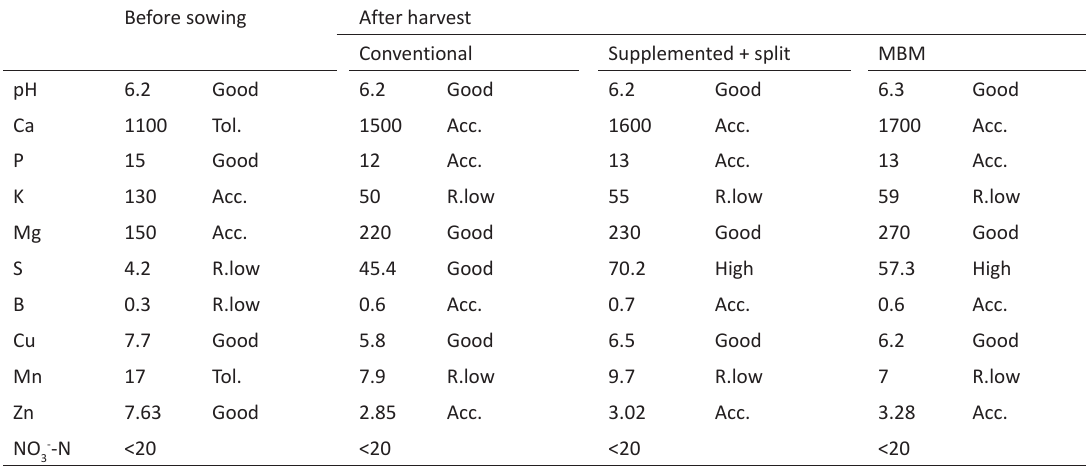
Table 6. Soil analysis results from before sowing and after harvest in 2010 for the carrot trial (mg l -1 , except pH and NO 3- N kg ha -1 ) Before sowing After harvest Conventional Supplemented + split